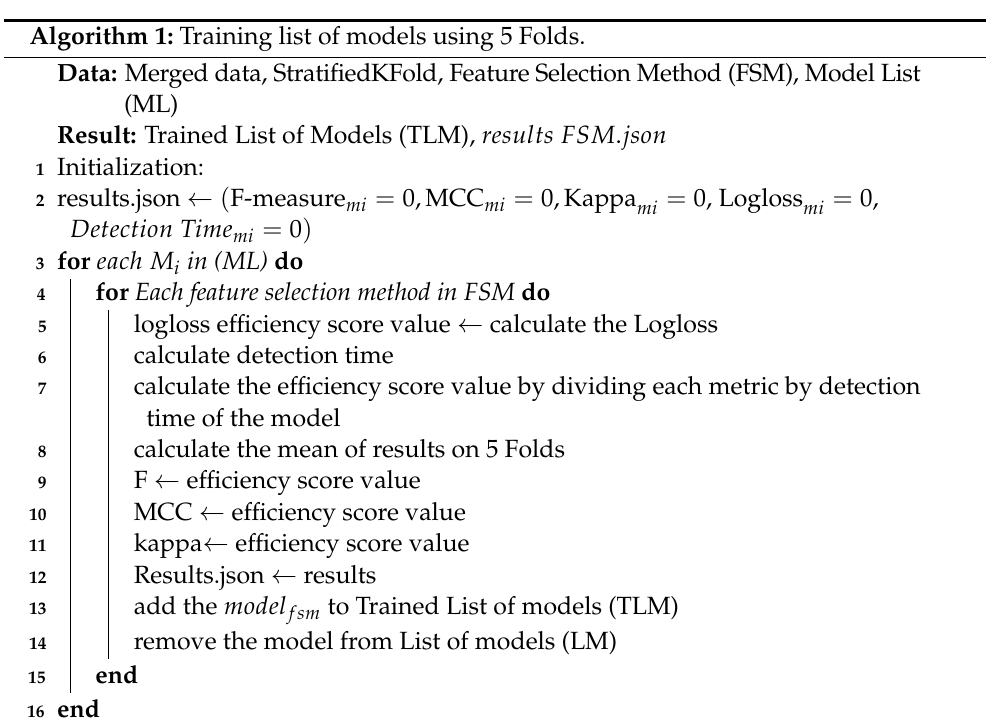
Algorithm 1: Training list of models using 5 Folds.